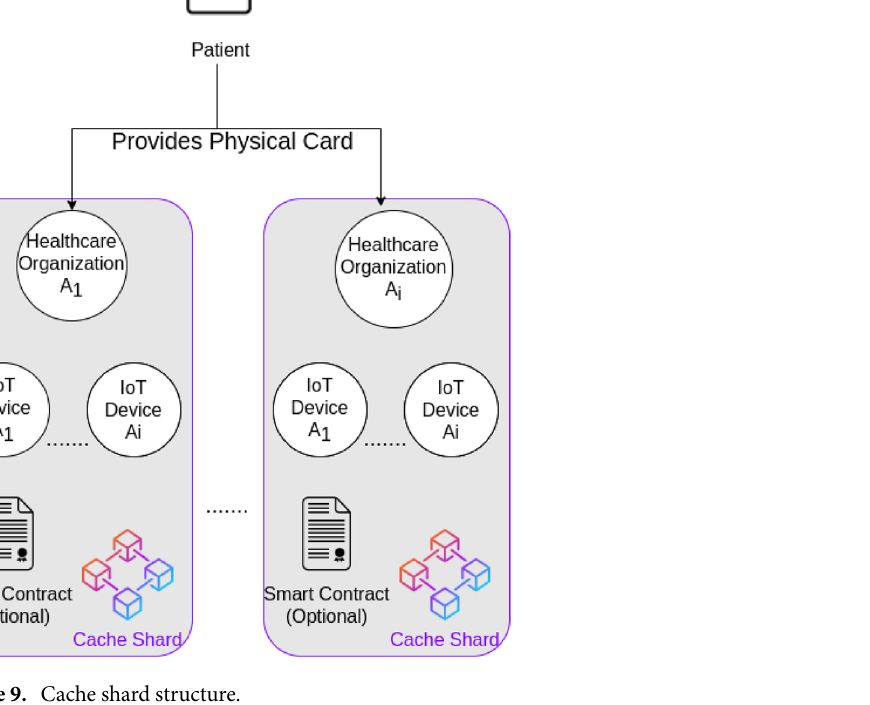
Figure 9. Cache shard